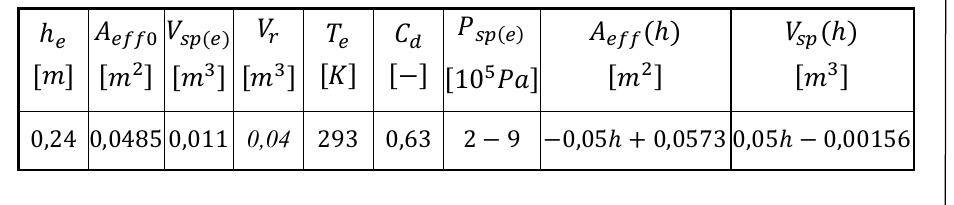
Table 1 – Working parameters for the simulation Tabela 1 –